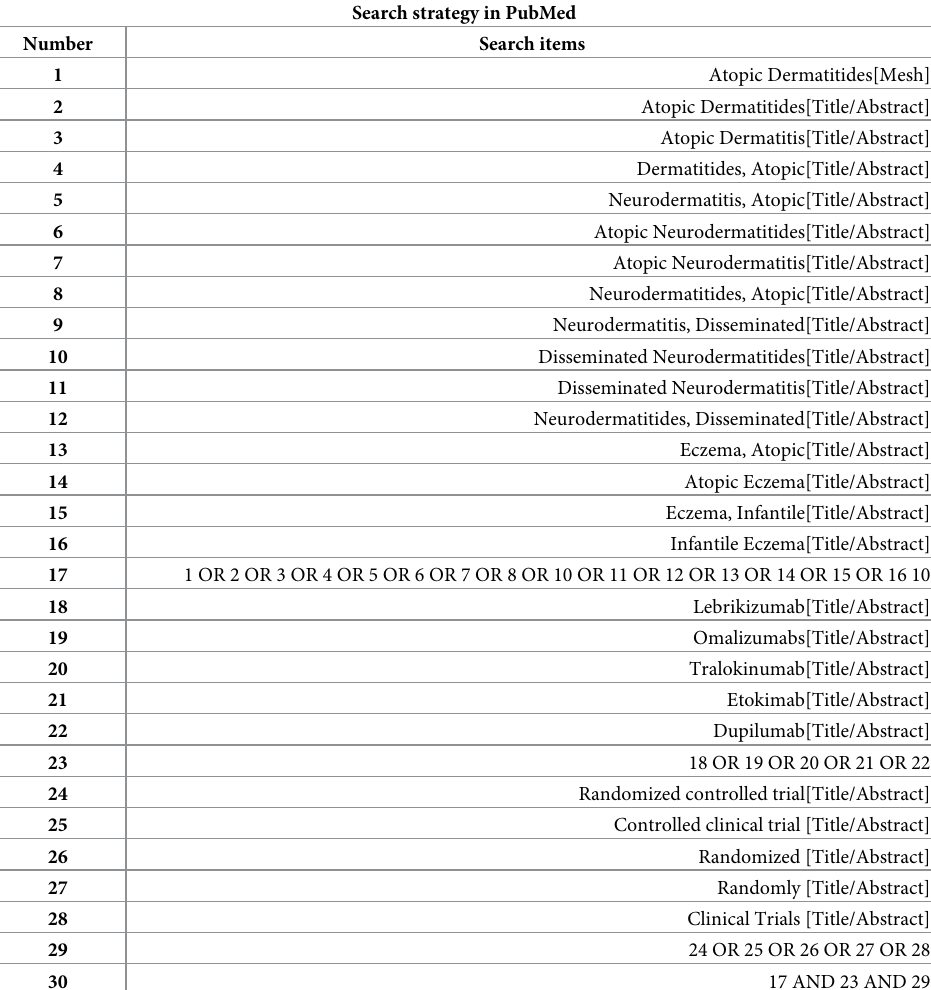
Table 1. Search strategy for pubmed